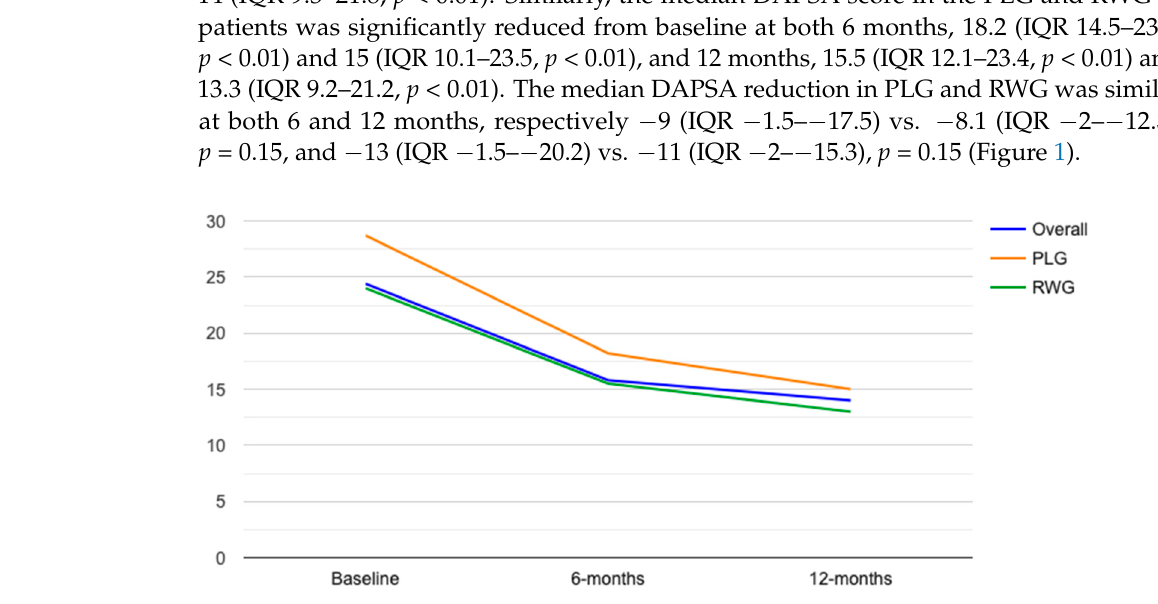
Figure 1. DAPSA median values at baseline, 6 months, and 12 months in overall cohort (blue line), PLG (orange line), and RWG (green line).